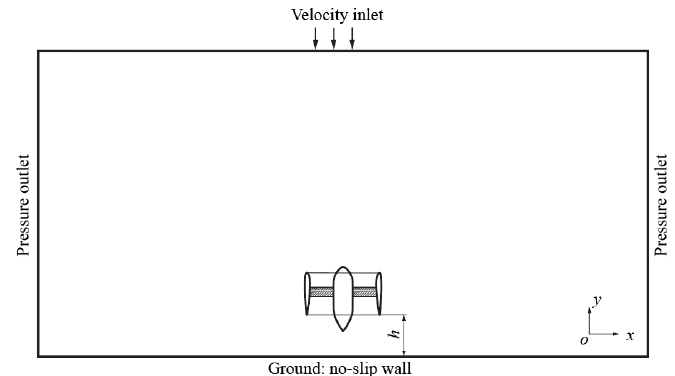
Figure 9. Boundary conditions when hovering in ground effect.